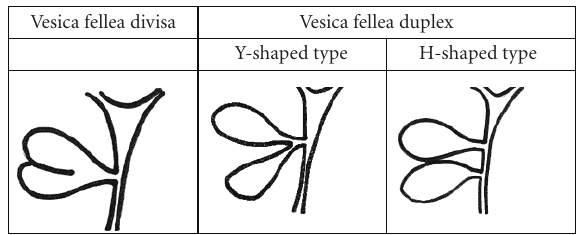
Figure 4: Boyden’s classification of gallbladder